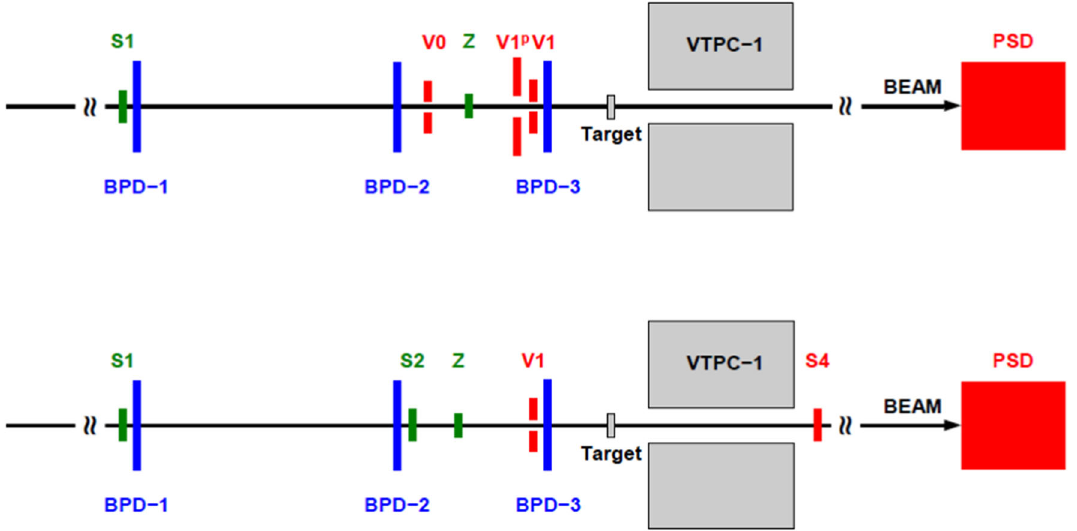
Fig. 2 The schematic of the placement of the beam and trigger detectors in high-momentum (top) and low-momentum (bottom) data taking configurations showing scintillation counters S, veto counters V, charge Cherenkov counter Z and beam position detectors BPD